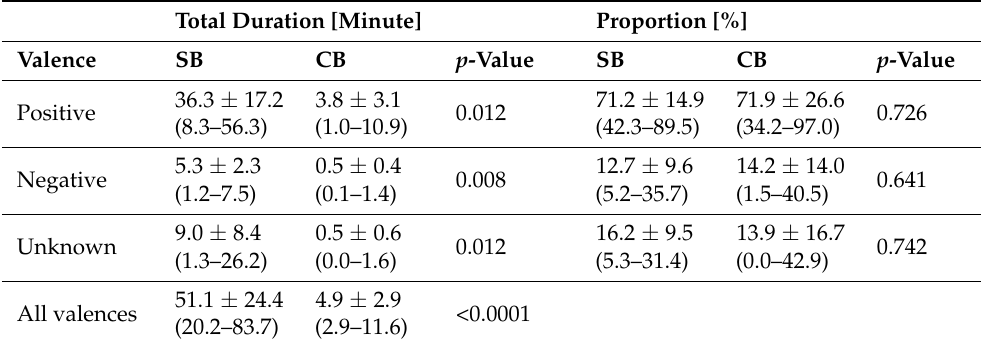
Table 3. Total duration (mean ± SD (range)) in minutes of social interactions over 24 h in the social box (SB) and the conventional box (CB) stabling by valence. The percentage indicates the proportion of the total interactions’ duration by valence.